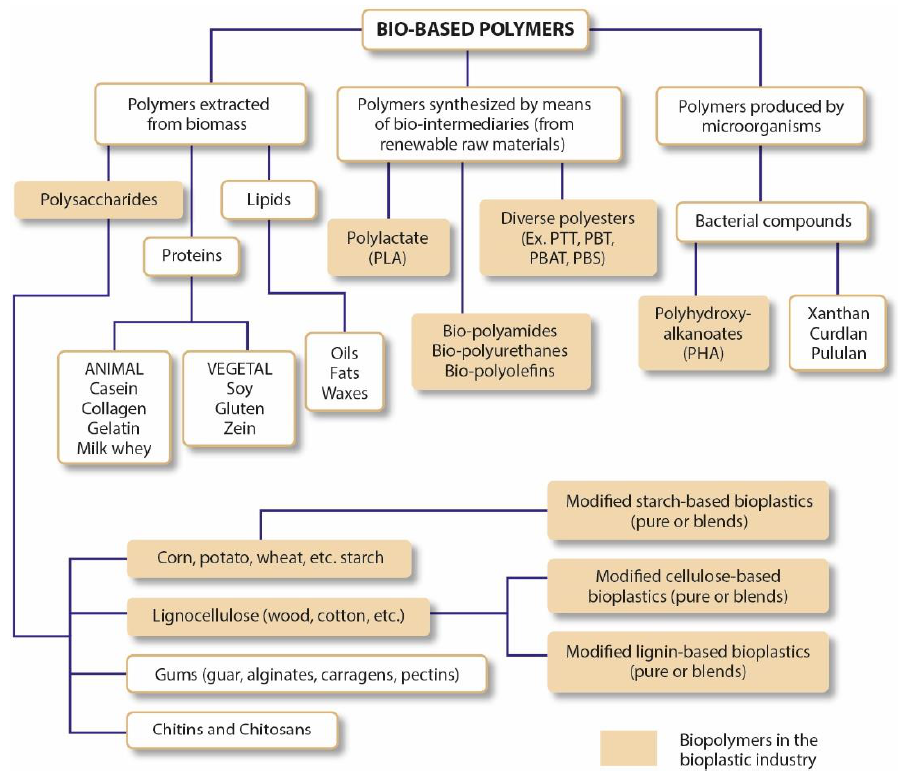
Figure 3. Types of bioplastics according to their raw material. Adapted from “Innovation and in-